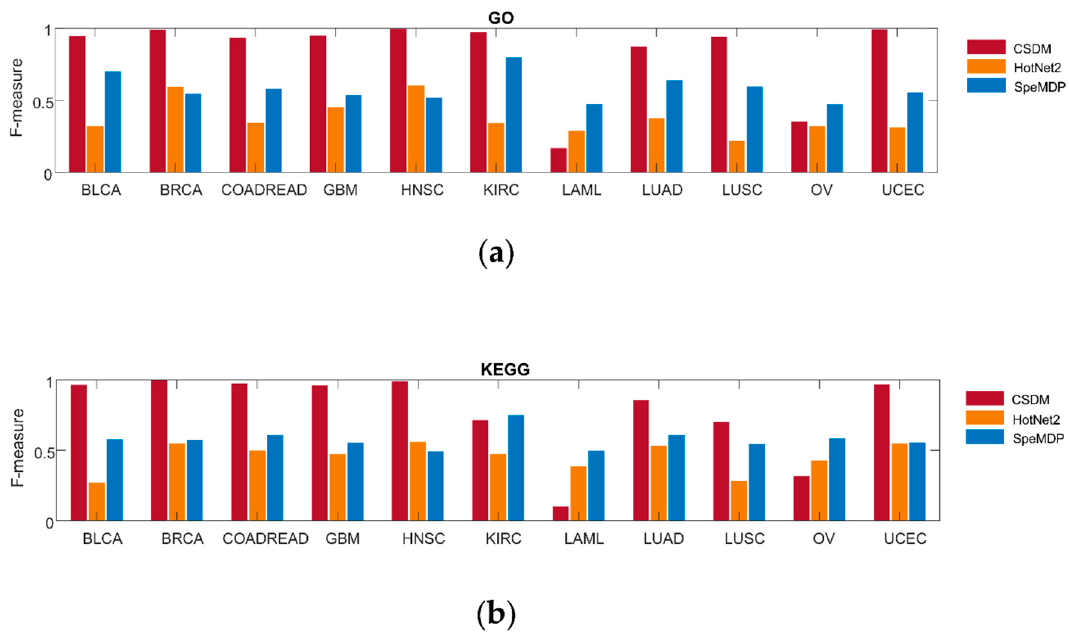
Figure 2. Comparison of CSDM (red), SpeMDP (yellow), and HotNet2 (blue) in GO ( a ) and KEGG ( b ) pathway enrichment in 11 different cancer types. The F-measure is used to represent the accuracy of the driver modules detected by each method.